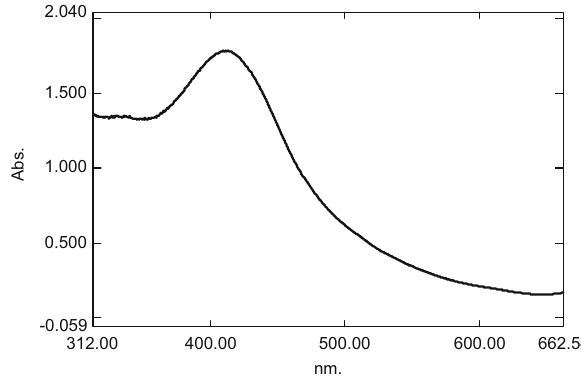
Figure 2: UV - Vis spectrum of V. jatamansi shoot AgNPs in sample containing 1:5 ( 1 mL of AgNO 3 :5 mL extract ) showing AgNPs SPR peak at